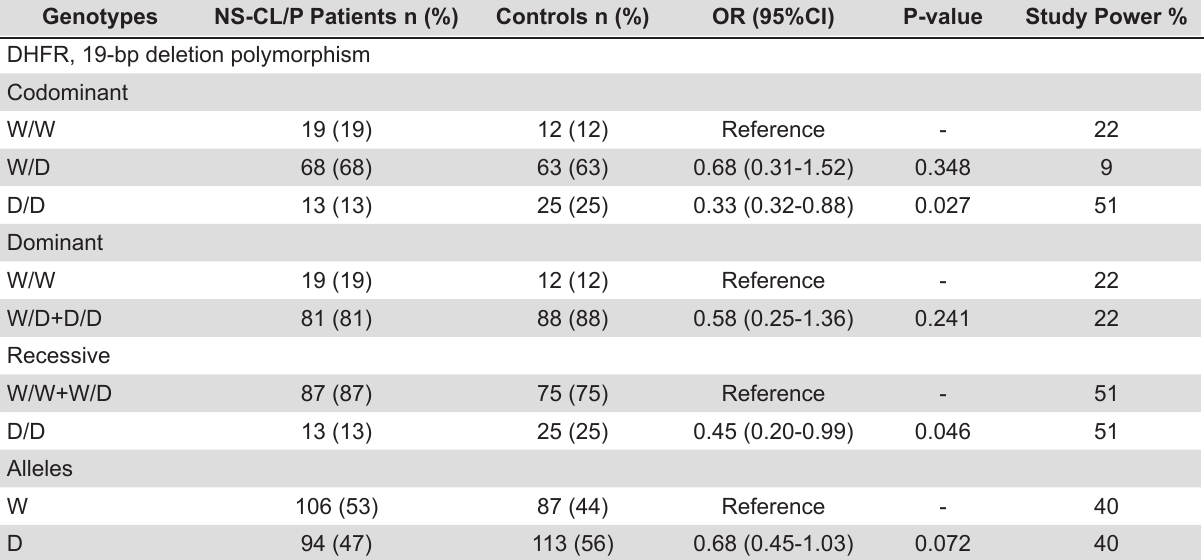
The 19-bp deletion polymorphism of dihydrofolate reductase (DHFR) and nonsyndromic cleft lip with or without cleft palate: evidence for a protective Table 1- Genotype and allele frequencies of DHFR 19-bp deletion polymorphism between patients with nonsyndromic cleft lip and/or cleft palate (NS-CL/P) and control subjects